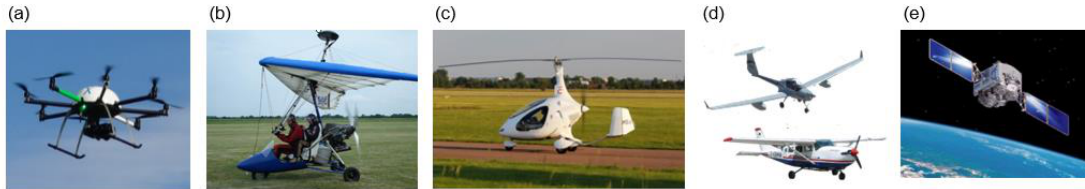
Figure3. Di ff erentair-andspaceborneremotesensingplatformsforassessinggeodiversityandgeotraits, Figure 3. Different air- and spaceborne remote sensing platforms for assessing geodiversity and ( a )unmannedaerialvehicles(UAV,ordrone), ( b )microlight-gravity-controlled( c )gyrocopter-microlight geotraits, ( a ) unmanned aerial vehicles (UAV, or drone), ( b ) microlight-gravity-controlled ( c ) helicopter, ( d, top) Ecodemona, ( d, bottom) Cessna, ( e ) gyrocopter-microlight helicopter, ( d, top) Ecodemona, ( d, bottom) Cessna, ( e ) satellite.